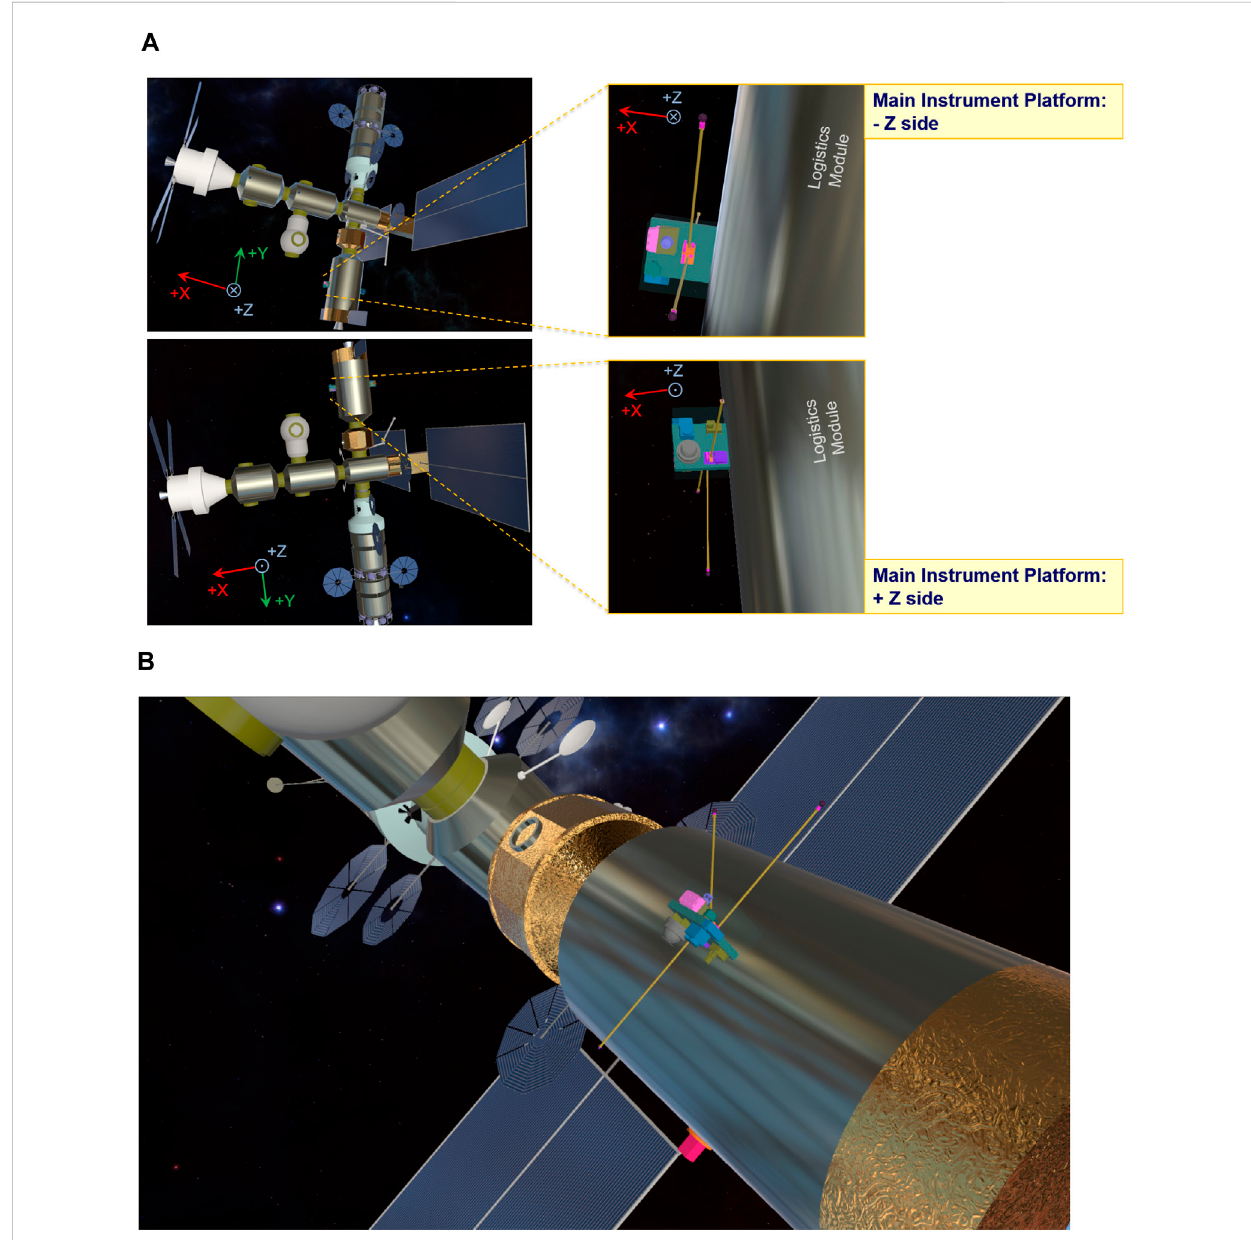
FIGURE 17 The two-sided Main Instrument Platform, mounted on the Logistics Module (A) , and in perspective view (B) . The “ magenta cube ” , on the side of the Logistics Module, is the “ standalone ” cGCRD instrument.